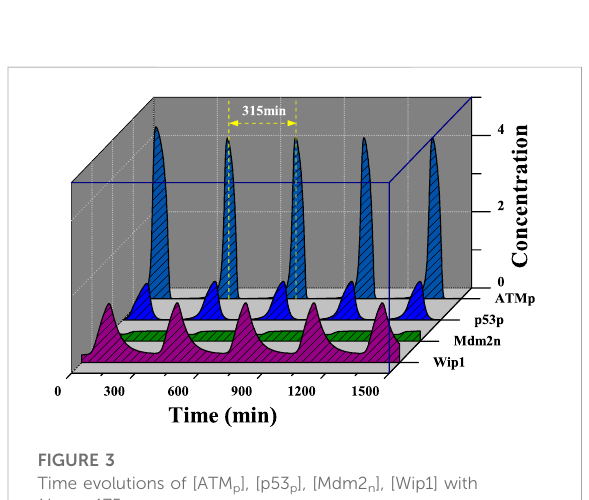
FIGURE 2 Deterministic analysis of the model. (A) The bifurcation diagram of total p53 concentration with N dsb , the black solid line and dotted line represent stable and unstable states respectively, the solid circle represents the HB point, and the blue curve represents the maximum and minimum of [p53] in the limit cycle. (B) The change of [p53] with N dsb . Here [p53] = [p53 u ]+[p53 p ].